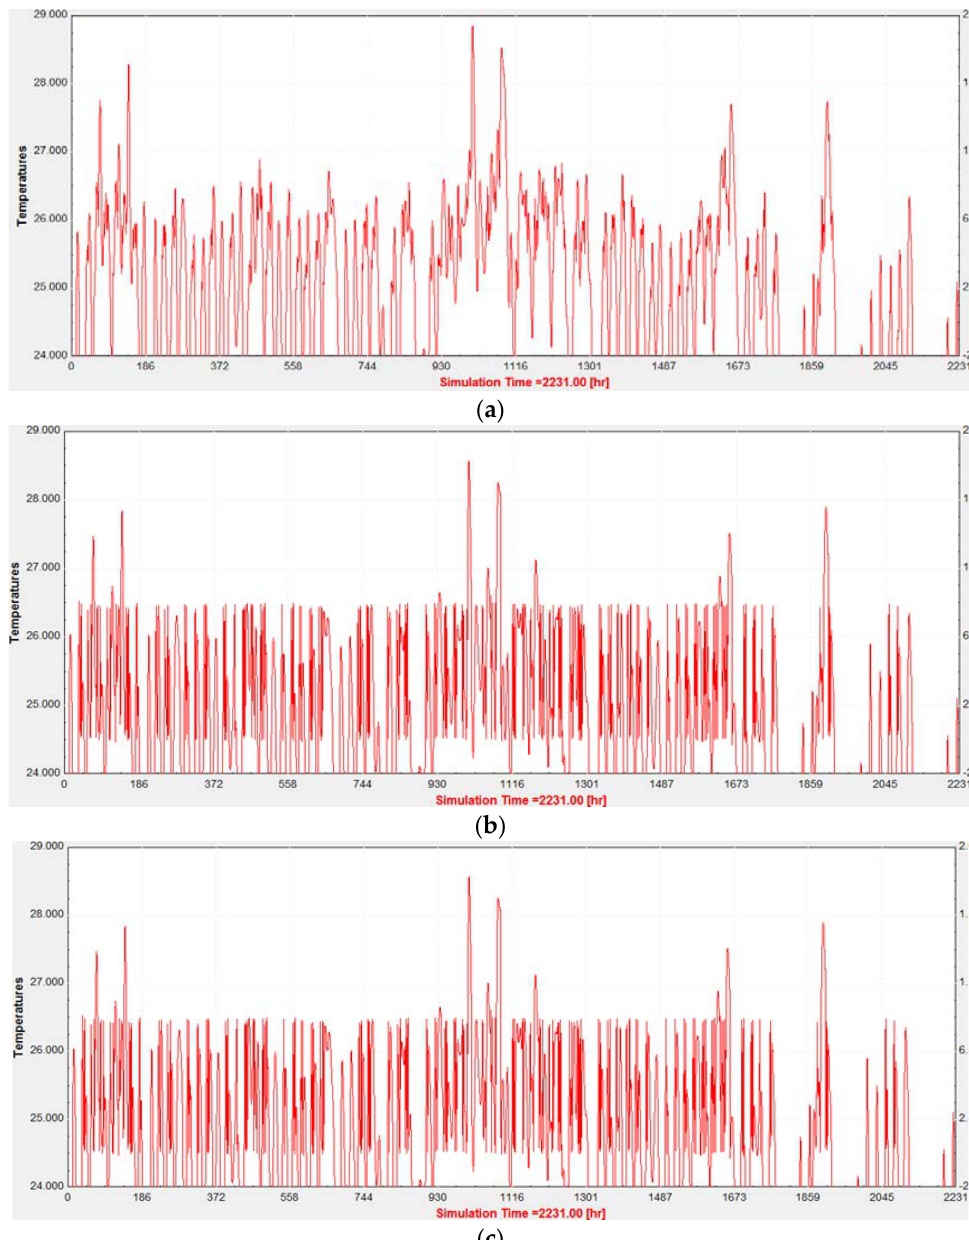
Figure 11. ( a ) Room temperature simulation results under LFF control; ( b ) Room temperature Figure11. ( a ) Room temperature simulation results under LFFcontrol; ( b ) Room temperature simulation simulation results under RTF control; ( c ) Room temperature simulation results under SWT control. results under RTF control; ( c ) Room temperature simulation results under SWT